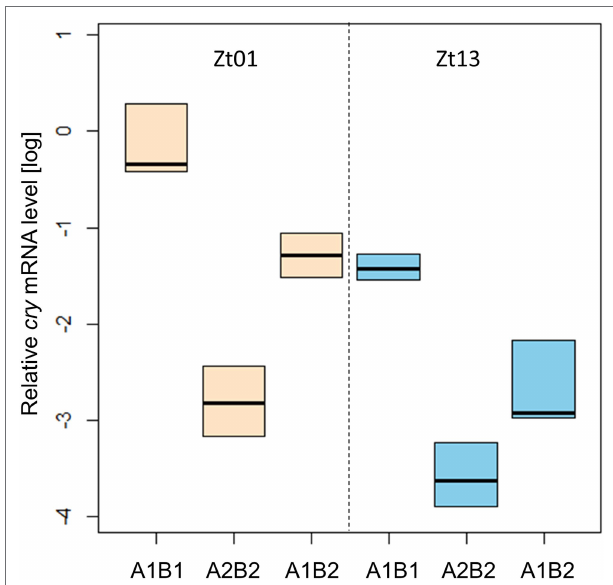
FIGURE 9 | Transcriptional variation among cry haplotypes in transgenic flies. qPCR analysis of cry transcription in heads from flies sampled at Zt01 (bisque shaded) and Zt13 (blue). Boxplot represents the median and the IQR obtained from four biological replicates. The gene Rpl32 was used as a reference